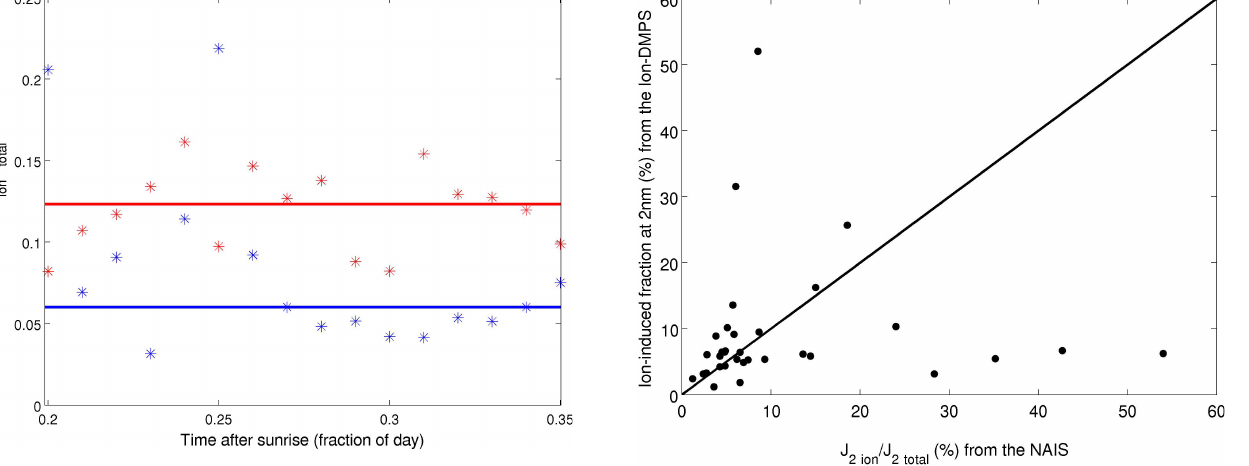
Fig. 2b. The Ion-induced fraction calculated for events of 2006 and 2007 are compared for the NAIS measurements and method and the Ion-DMPS measurements and